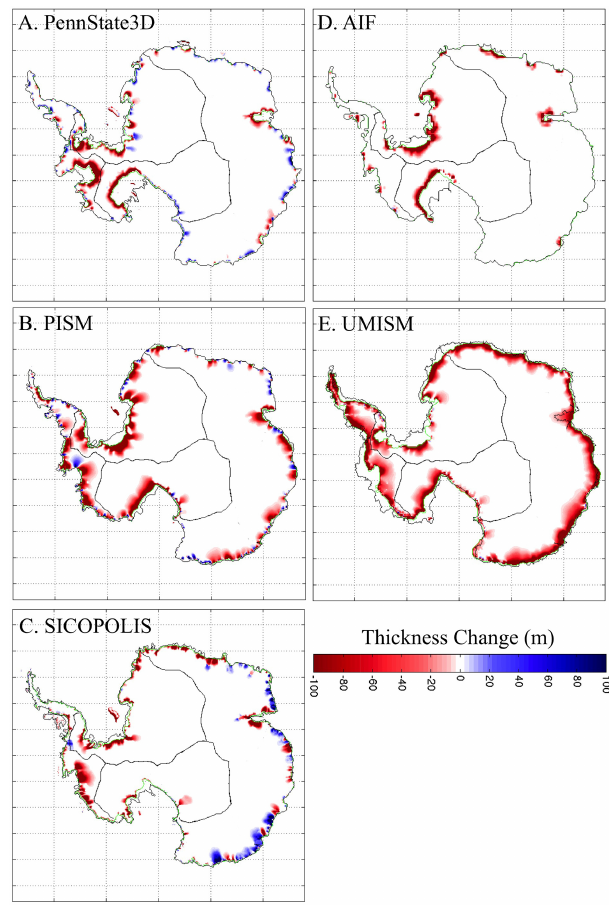
Figure 5. Ice-thickness change after 100 years under the SeaRISE experiment with homogeneous increase in basal ice-shelf melting of 20ma − 1 (experiment M2 and Fig. 8 in Nowicki et al., 2013a). Due to their coarse resolution, some models with explicit represen- tation of ice shelves such as the PISM model tend to underestimate the length of the coastline to which an ice shelf is attached which might lead to an underestimation of the ice loss. The UMISM model assumes basal melting along the entire coastline which is likely to result in an overestimation of the effect. Black contours represent the initial grounding line which moved to the green contour during the M2 experiment after 100 years. Lines within the continent show the drainage basins as in Fig.